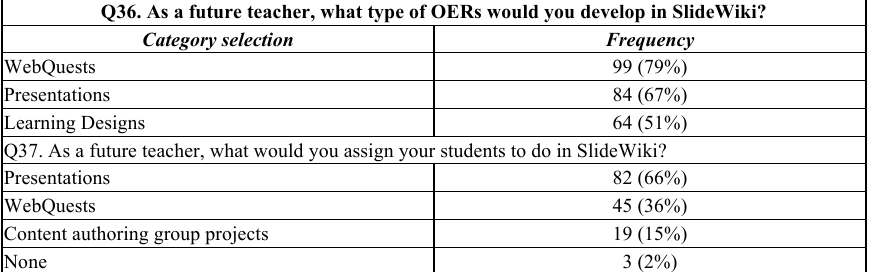
Table 7. Students’ answers to the multiple choice question Q36 and the open-ended question Q37 of Section